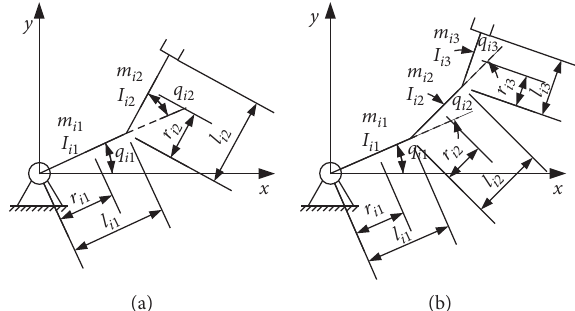
Figure 1: Mechanical structures of 2-DOF (a) and 3-DOF (b) robots.